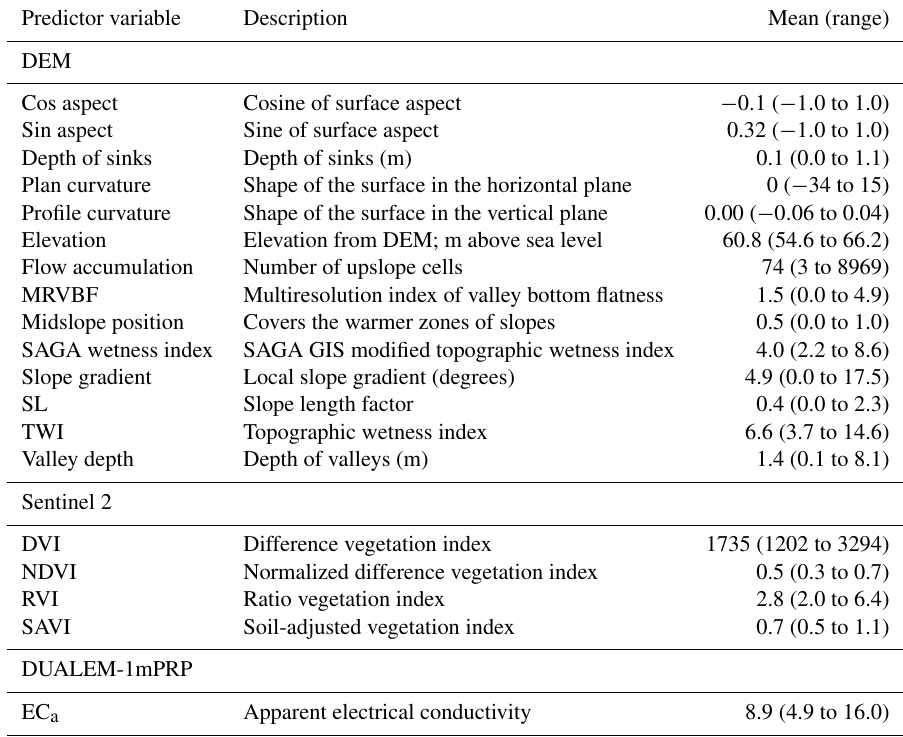
Table 1. Auxiliary data variables used as covariates in the study including the name, the description, the mean value and the range. Pouladi et al. (2019) describe the derivation of the variables.